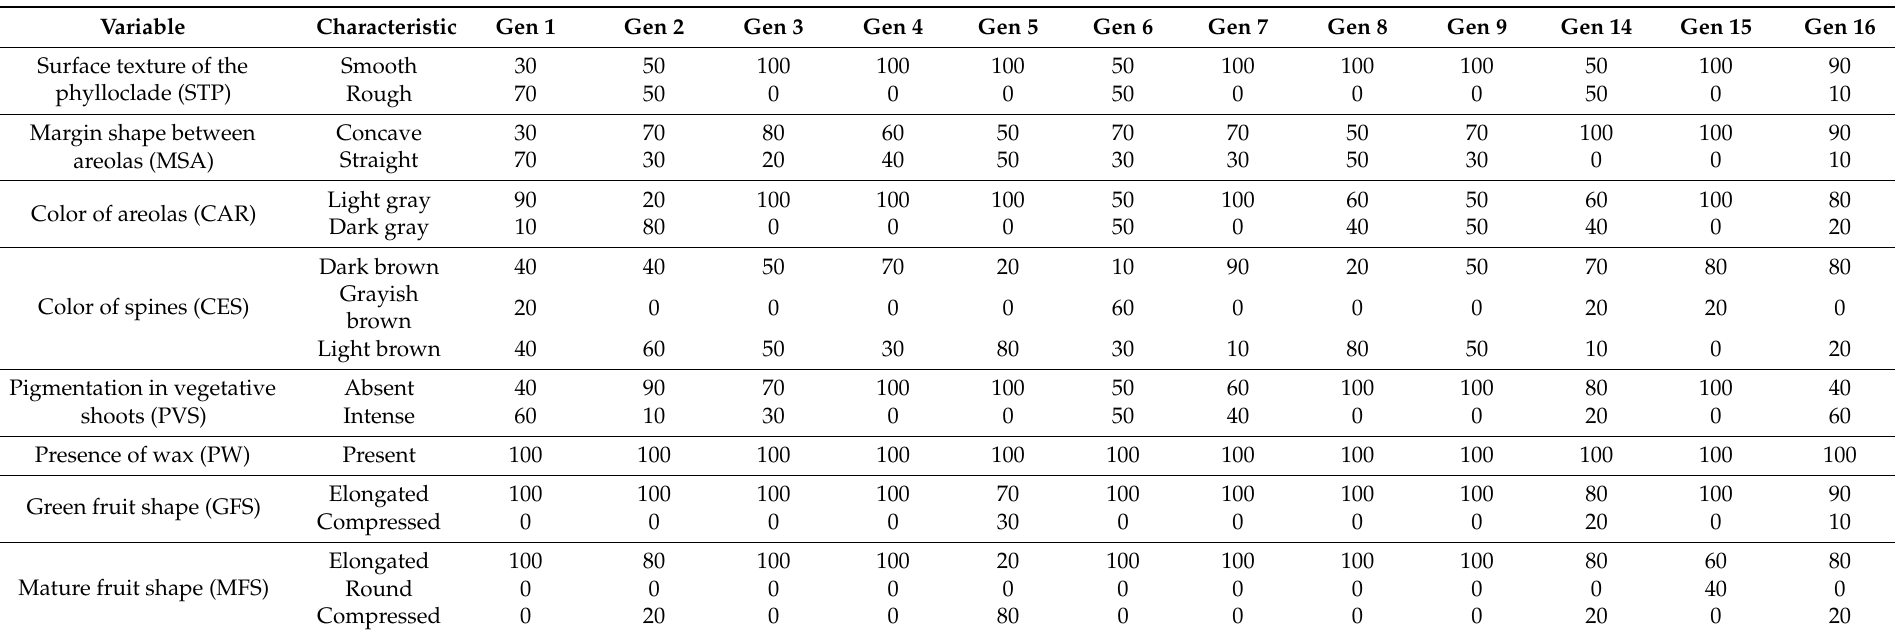
Table 8. Frequency analysis of the qualitative descriptors used in the morphoagronomic characterization of the yellow pitahaya genotypes in the covered system in the municipality of Miraflores, Boyac á